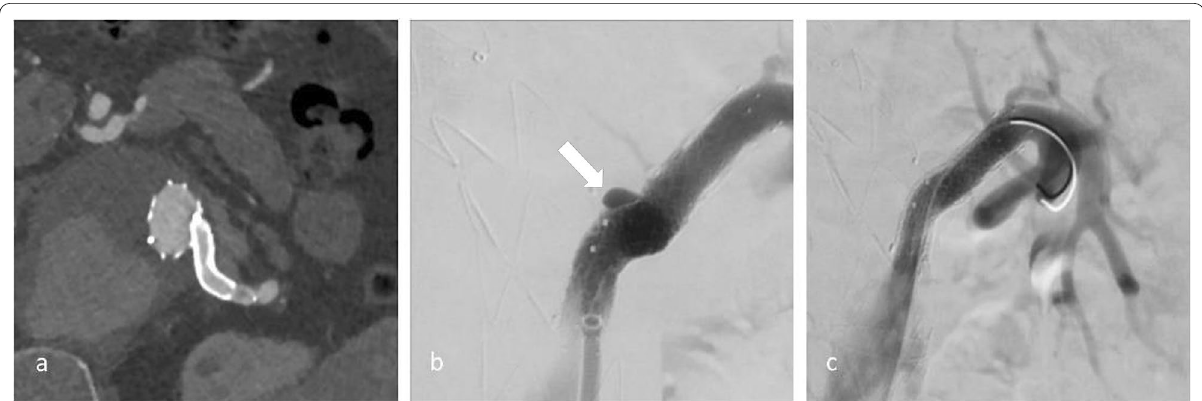
Fig. 6 In the same procedure as in Fig. 1, the left renal BSG was unsuspicious in CTA ( a ), but an incidental membrane disruption was detected at angiography ( b ) and successfully treated ( c